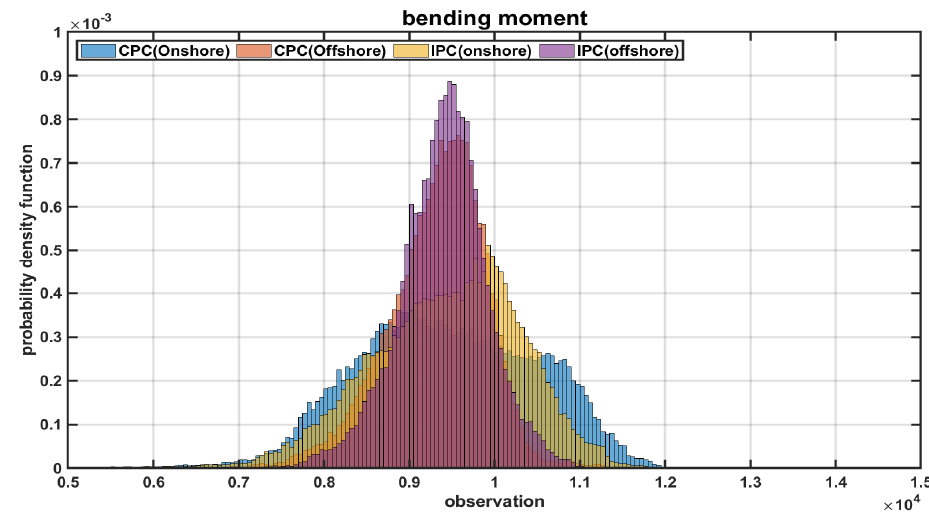
Figure 12. Histogram of blade bending moment of floating wind turbine based on pitch controller.